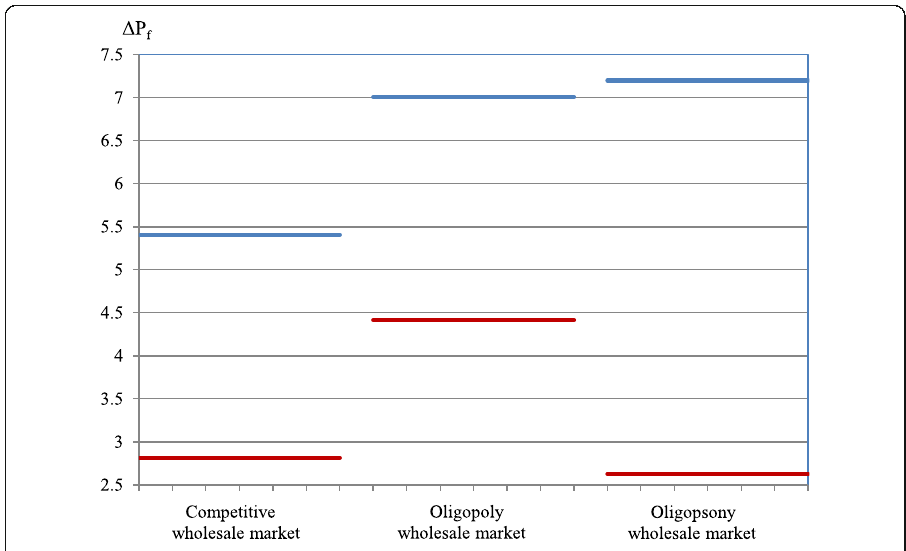
Fig. 5 Farm price increase ( Δ P f ) in two scenarios of anti-trust methods under various wholesale market structures. Note: The red lines represent the farm price increase ( Δ P f ) when only processors ’ buyer power is weakened (from M = 2 to M = 3). The blue lines represent the farm price increase ( Δ P f ) when both processors ’ buyer power (from M = 2 to M = 3) and retailers ’ seller power are weakened (from N = 2 to N = 3). The farm price increases (blue lines) are larger when the two forms of market power are jointly addressed